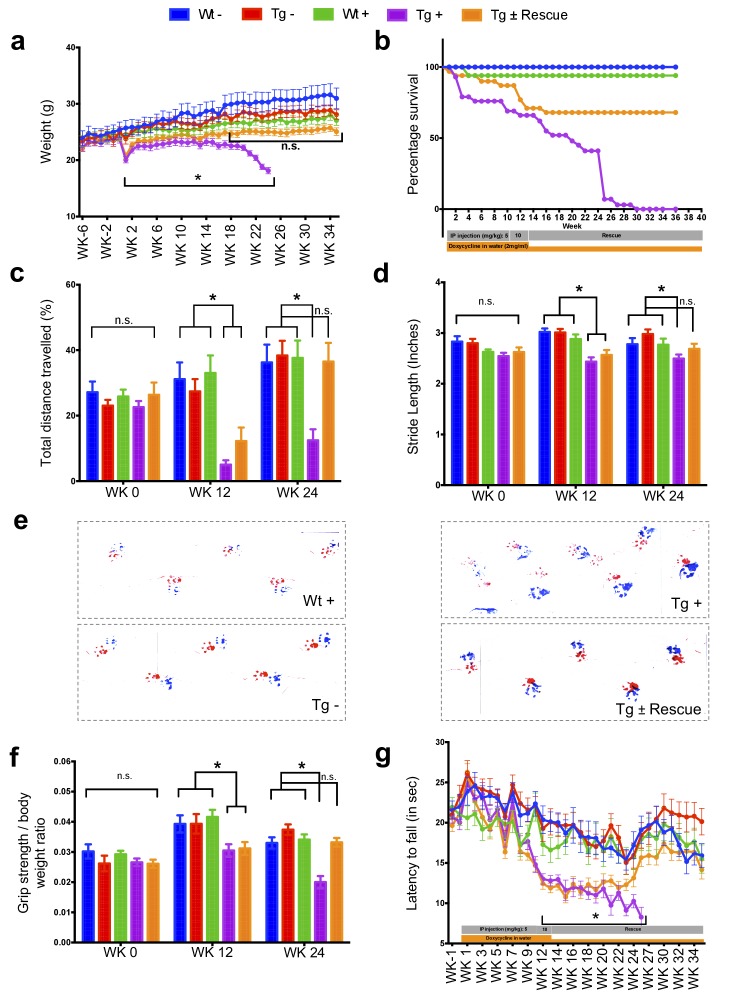
Neurological deficits due to frataxin knockdown.Body weight, survival, open field, gait analysis, grip strength and Rotarod in five groups of animals; wild-type mice with dox (Wt +, n = 16 (WK 0), n = 16 (WK 12), n = 16 (WK 24)) and without dox (Wt -, n = 16 (WK 0), n = 16 (WK 12), n = 16 (WK 24)), transgenic mice with dox (Tg +, n = 30 (WK 0), n = 21 (WK 12), n = 15 (WK 24)) and without dox (Tg -, n = 16 (WK 0), n = 15 (WK 12), n = 15 (WK 24)), and transgenic mice with dox removal (Tg ± Rescue, n = 30 (WK 0), n = 21 (WK 12), n = 20 (WK 24)). (a) Body weight from before 6 weeks and upto 34 weeks after dox treatment. (b) Survival was significantly diminished in dox treated Tg + animals, no mortality was observed after dox withdrawal (Tg ± Rescue). (c) Open field test showing significant decline in total distance traveled by the dox treatment transgenic animals (Tg +) at 12 and 24 weeks when compared across all other groups. After dox withdrawal, there were no differences between the rescue group (Tg ± Rescue) and the three control groups at week 24. (d) Gait footprint analysis of all five groups of mice at 0, 12, and 24 weeks was evaluated for stride length. Dox treated transgenic (Tg +) animals revealed abnormalities in walking patterns displaying significantly reduced stride length; however, the rescue group (Tg ± Rescue) displayed normal stride length when compared to other groups. (e) Representative walking footprint patterns. (f) Grip-strength test, dox treated transgenic (Tg +) mice had reduced forelimb grip strength at 12 and 24 weeks when compared across all other groups. After dox withdrawal, there were no significant differences between the rescue group (Tg ± Rescue) and the three control groups at week 24. (g) Rotarod test in mice upto 34 weeks after dox treatment. Dox treated transgenic (Tg +) animals stayed less time on the Rotarod than the control groups, although after dox withdrawal, there was no significant difference between the rescue group (Tg ± Rescue) and the three control groups. Values between all five groups are shown as mean ±SME. Two-way ANOVA test *p≤0.001; n.s., not significant.10.7554/eLife.30054.009Figure 2—source data 1.This spreadsheet contains the raw data which was used to generate the graphs shown in Figure 2 after frataxin knockdown during various behavioral tests in FRDAkd and control animals.